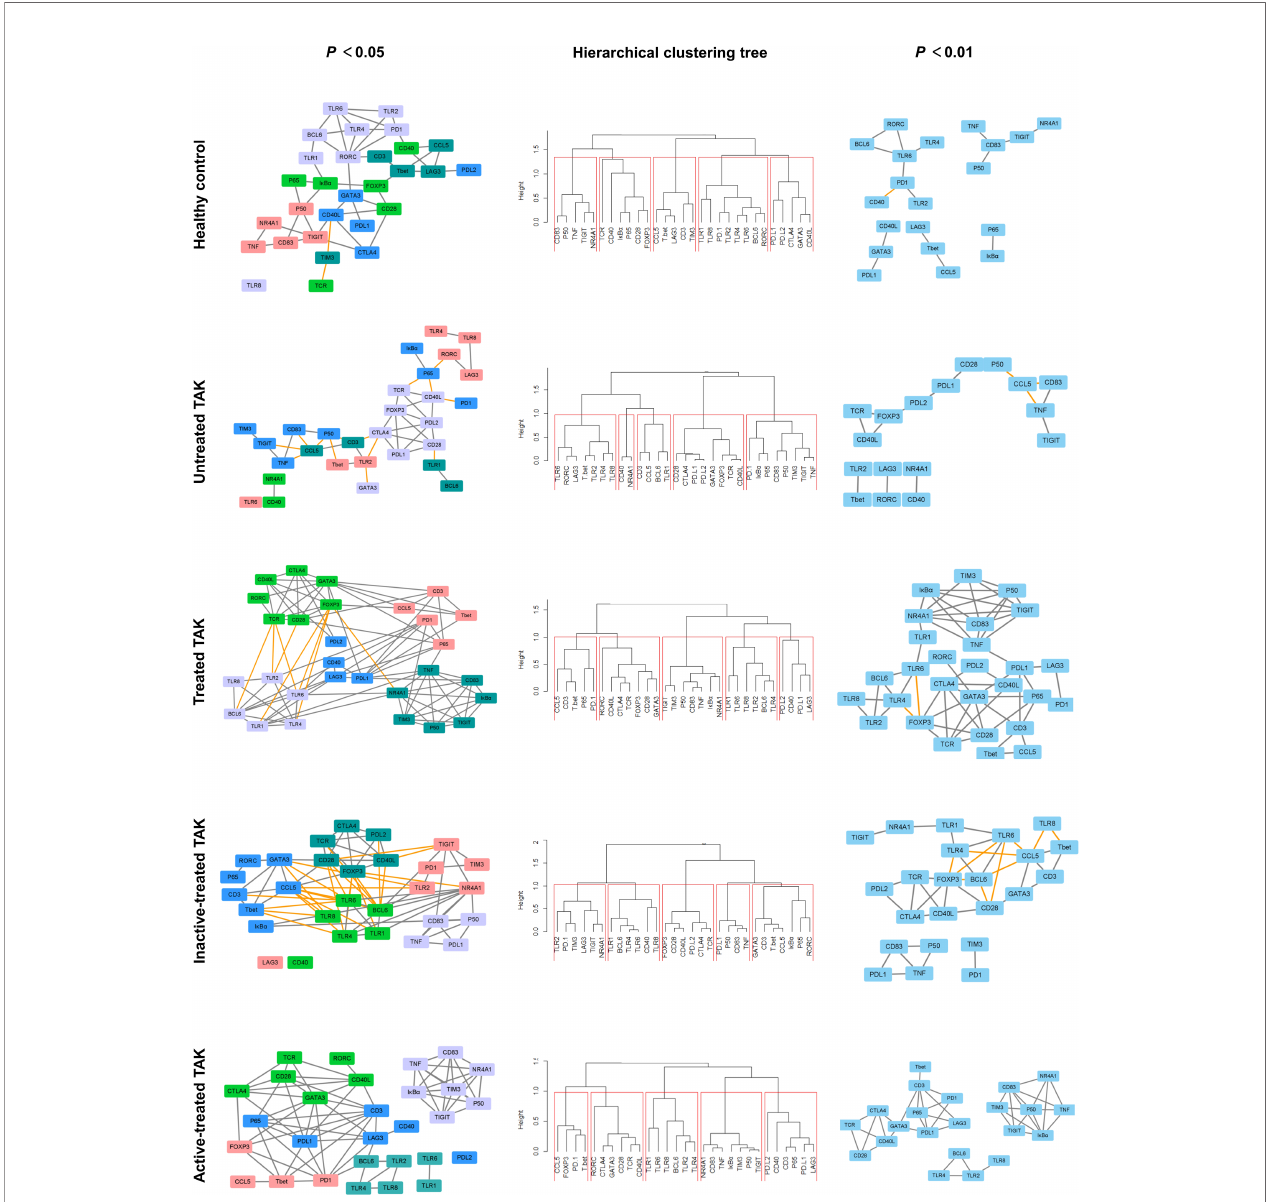
FIGURE 5 | Dynamic gene co-expression networks based on Pearson correlation. Left panel, the gene co-expression networks consisting of correlation with a p - value less than 0.05. Right panel, to more clearly demonstrate this feature, only the high correlations (de fi ned as | r| > 0.73, p < 0.01) were shown. Middle panel, the hierarchical clustering trees using complete method. As a result, genes were organized into 5 clusters by cutting the clustering tree at the height of 1.0, which was indicated by red frames. Genes belonging to the same cluster were like to have similar functions and were labeled with the same color. The negative correlation was indicated by the yellow edge, while the positive correlation was gray in the